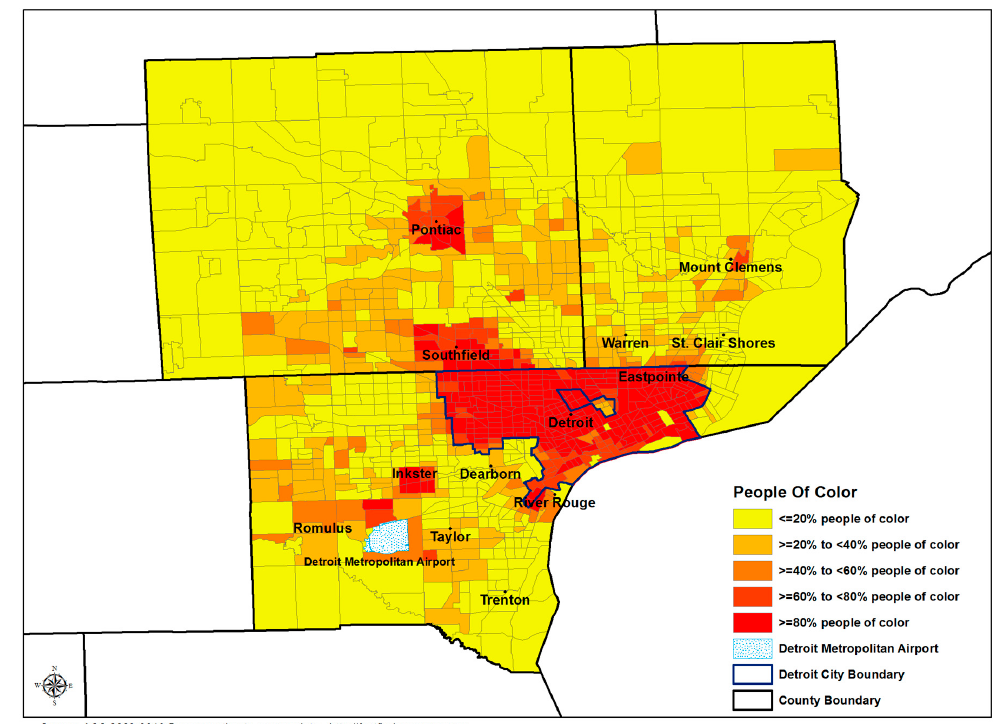
Figure 1. Proportion of persons of color at the census tract level, Detroit metropolitan area.